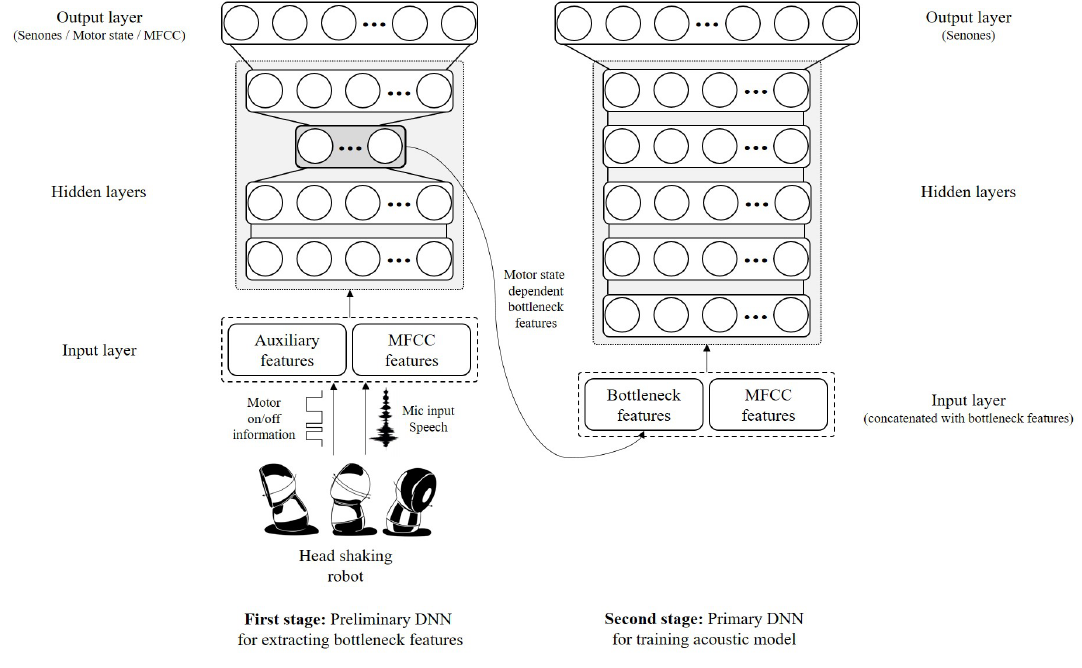
Figure 4. Framework of the proposed ASR system employing latent